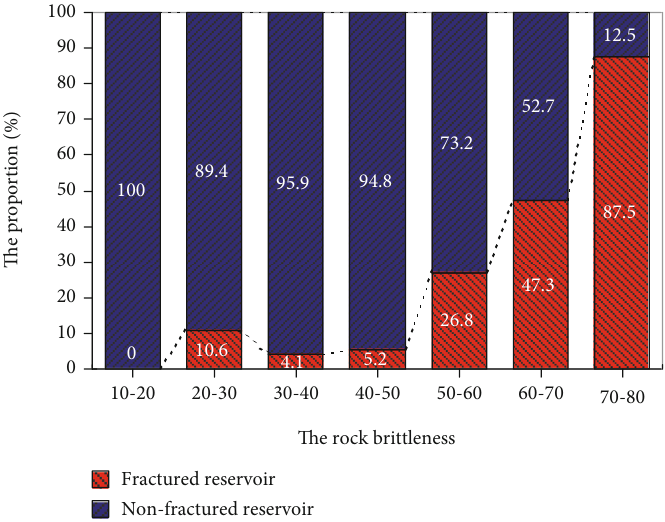
Figure 2: Brittleness and nature fracture relation chart.